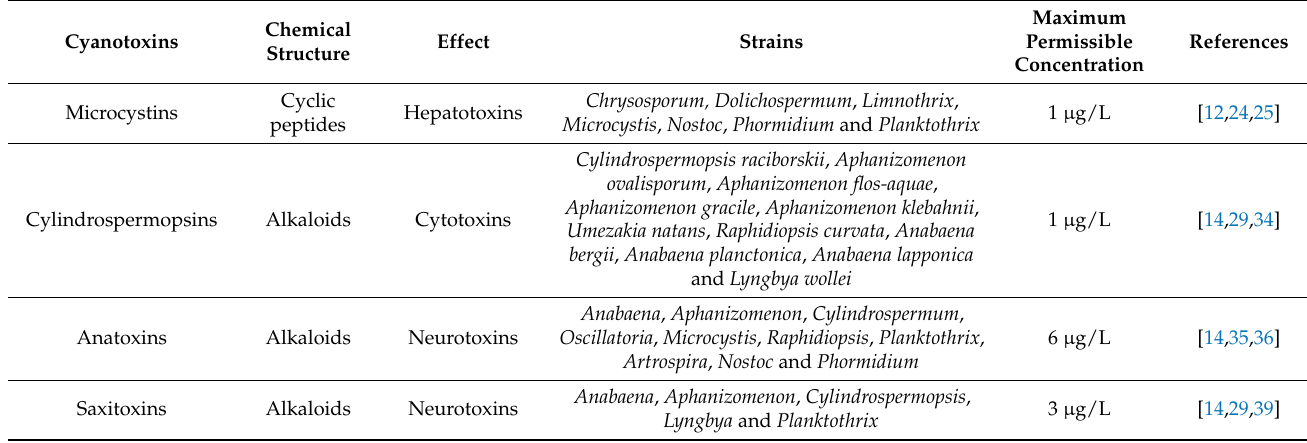
Table 1. Summary of the cyanobacterial toxicity associated with CyanoBlooms.